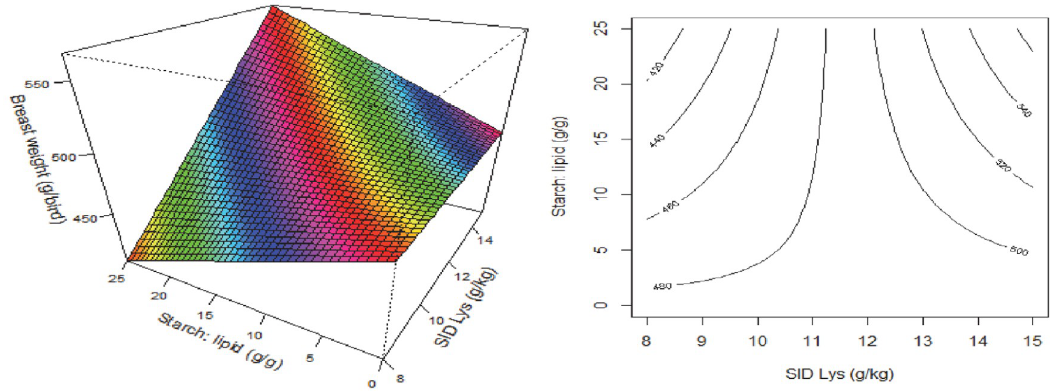
Fig 5. Response surface and contour plots describing relationships between breast weight (g/bird) and digestible lysine concentration (SID Lys) and starch to lipid ratios (S:L) in broiler chickens.